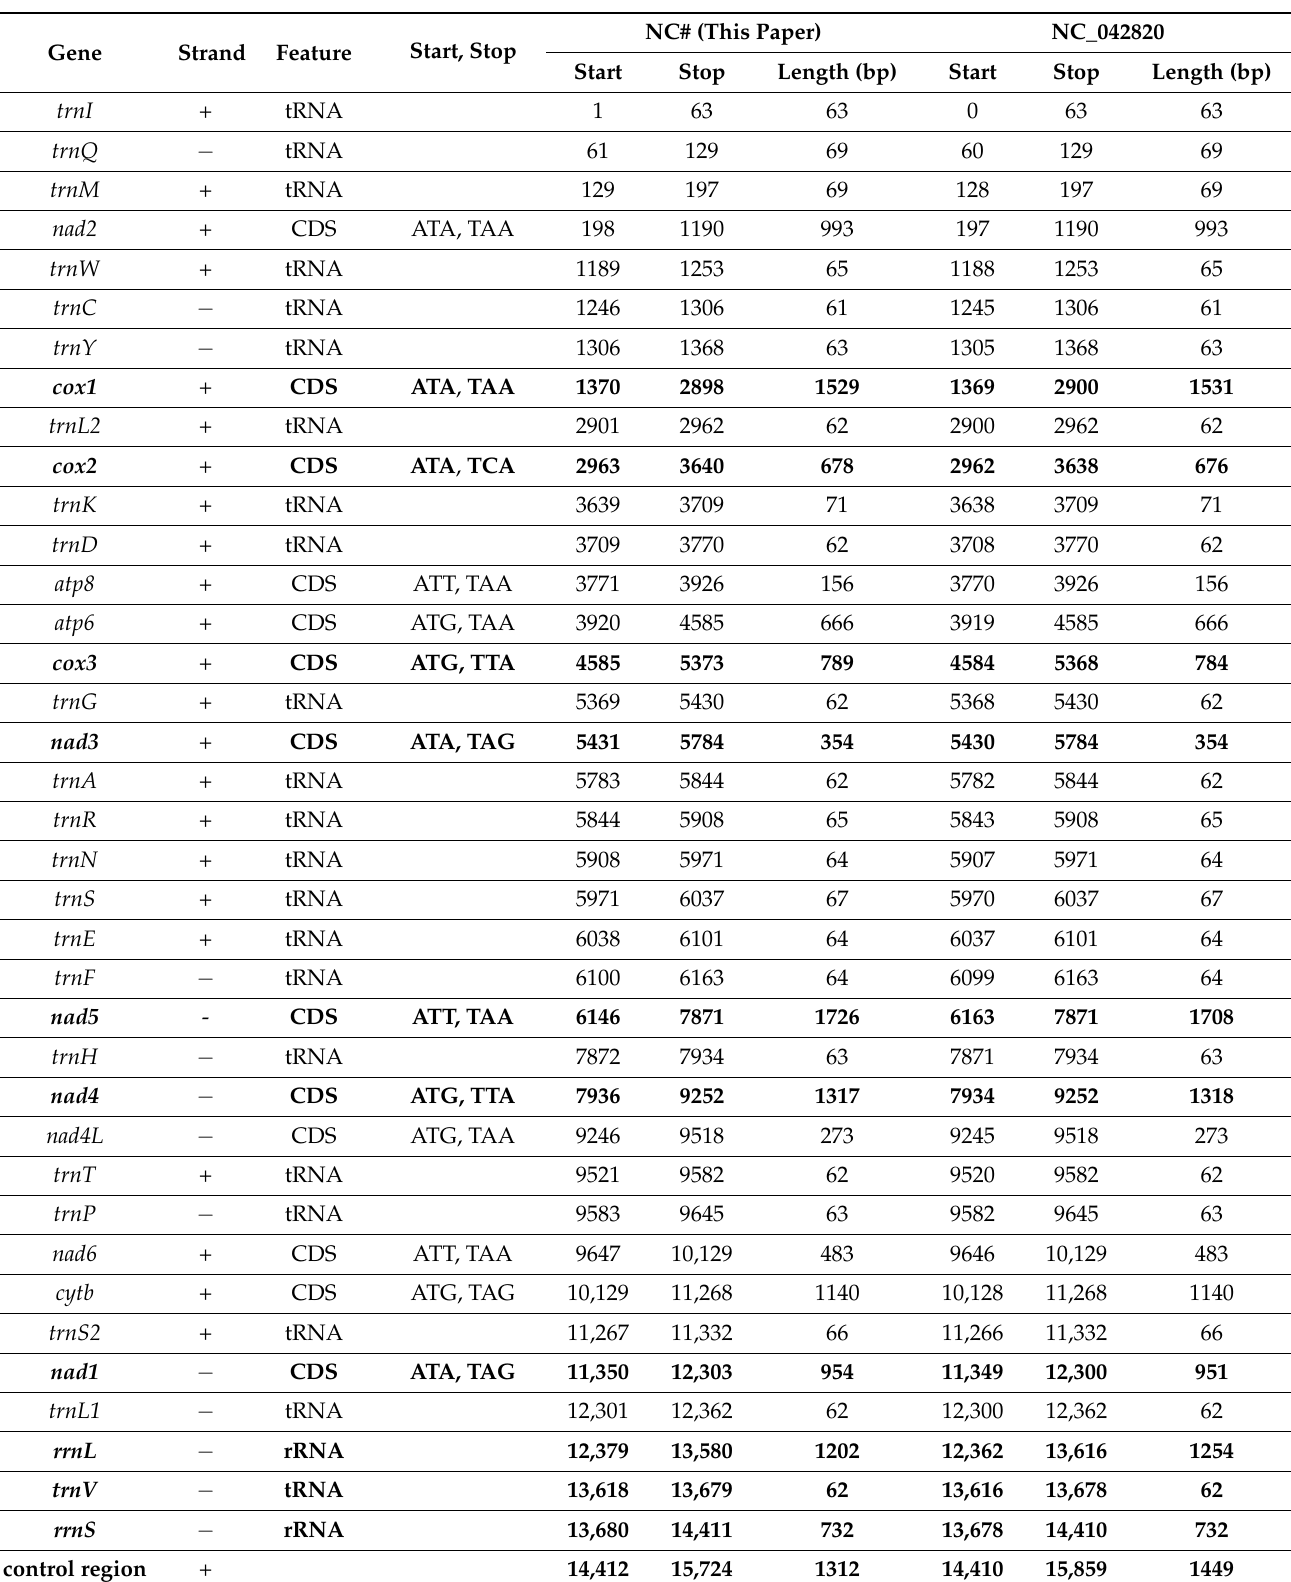
Table 1. Comparison of Rhyzopertha dominica mitochondrial genome sequence MW020612 (this paper) and NC_042820.1. Start/stop are provided for protein-coding sequences. Bolded entries are differences among the two sequences.